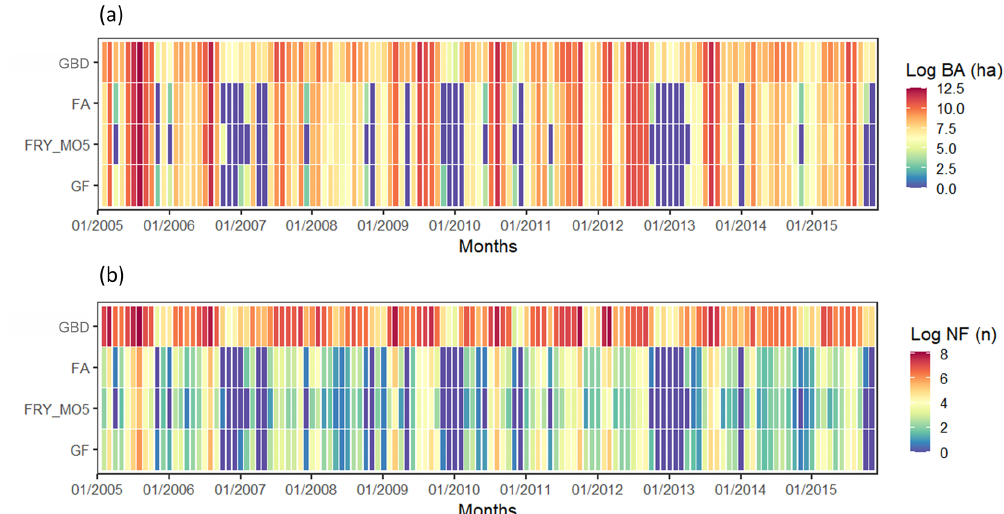
Figure 3. (a) Monthly burned area and (b) number of fires ( > 1ha) in each fire dataset across the southwestern Mediterranean Basin over 2005–2015.